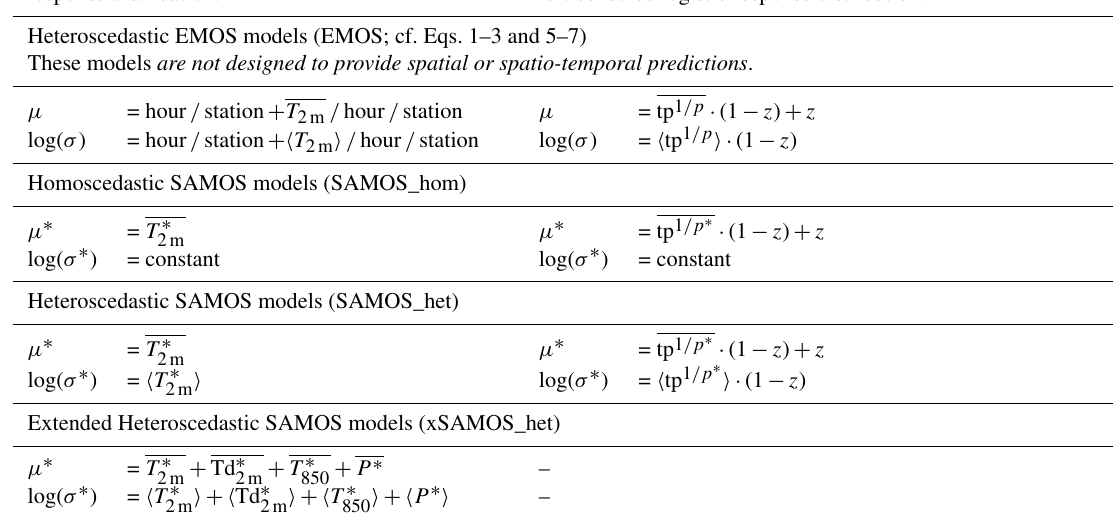
Table 1. Statistical model specification for 2m temperature (left) and 24h precipitation sums (right). For each model the linear predictors for µ and log( σ ) are shown. Superscript asterisk indicate variables on the standardized anomaly scale (SAMOS). T 2m , Td 2m , T 850 , P , and tp are the 2m temperature, 2m dew point temperature, temperature in 850hPa, surface pressure, and total precipitation ensemble forecasts respectively. X are ensemble means, (cid:104) X (cid:105) denote ensemble log-standard deviations. X / hour and X / station are interactions between X and the “time of the day” and/or the “station”. Models for 2m temperature using a Gaussian Models for 24h precipitation sums using a power-transformed response distribution. left-censored logistic response